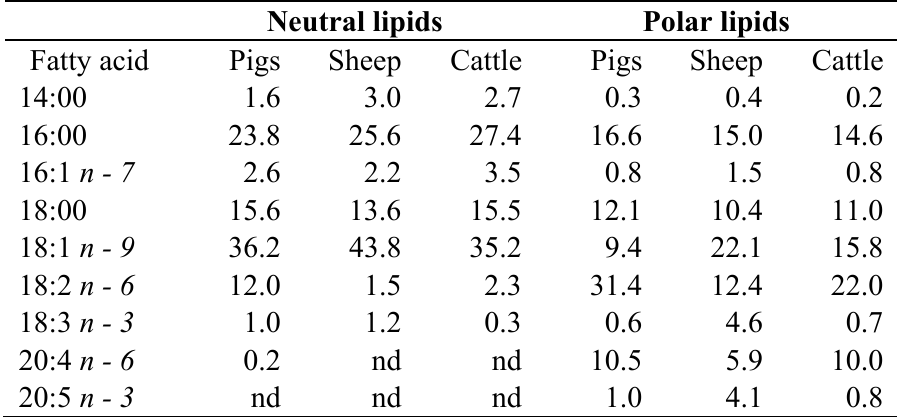
Table 2. Fatty acids composition (%) triacylglycerol (neutral lipids) and phospholipids (polar lipids) of the longissimus muscle in pigs, sheep and